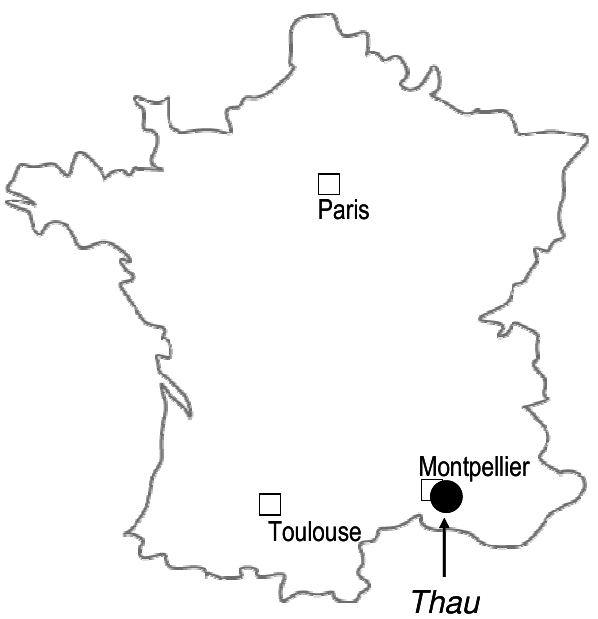
Figure 1. Location of Thau watershed (France). 4 Fig. 1. Location of Thau watershed